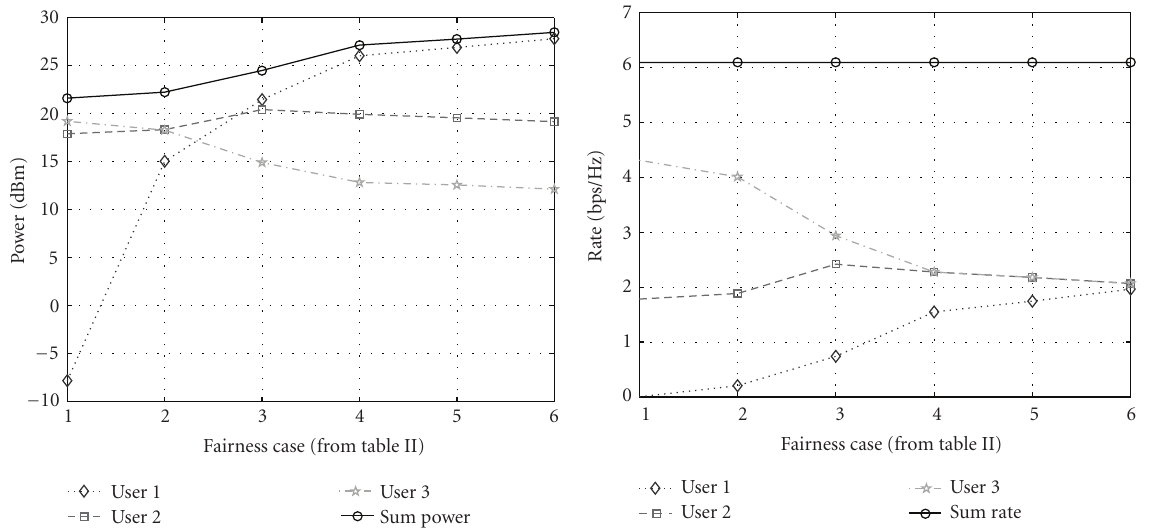
(b) Theindividualratesinthesixfairnesscasesthatwestudy.Thesum rate is kept constant (2bps/Hz/cell), but this sum rate is “distributed” unequally (Case 1) or nearly equally (Case 6) in the di ff erent cases